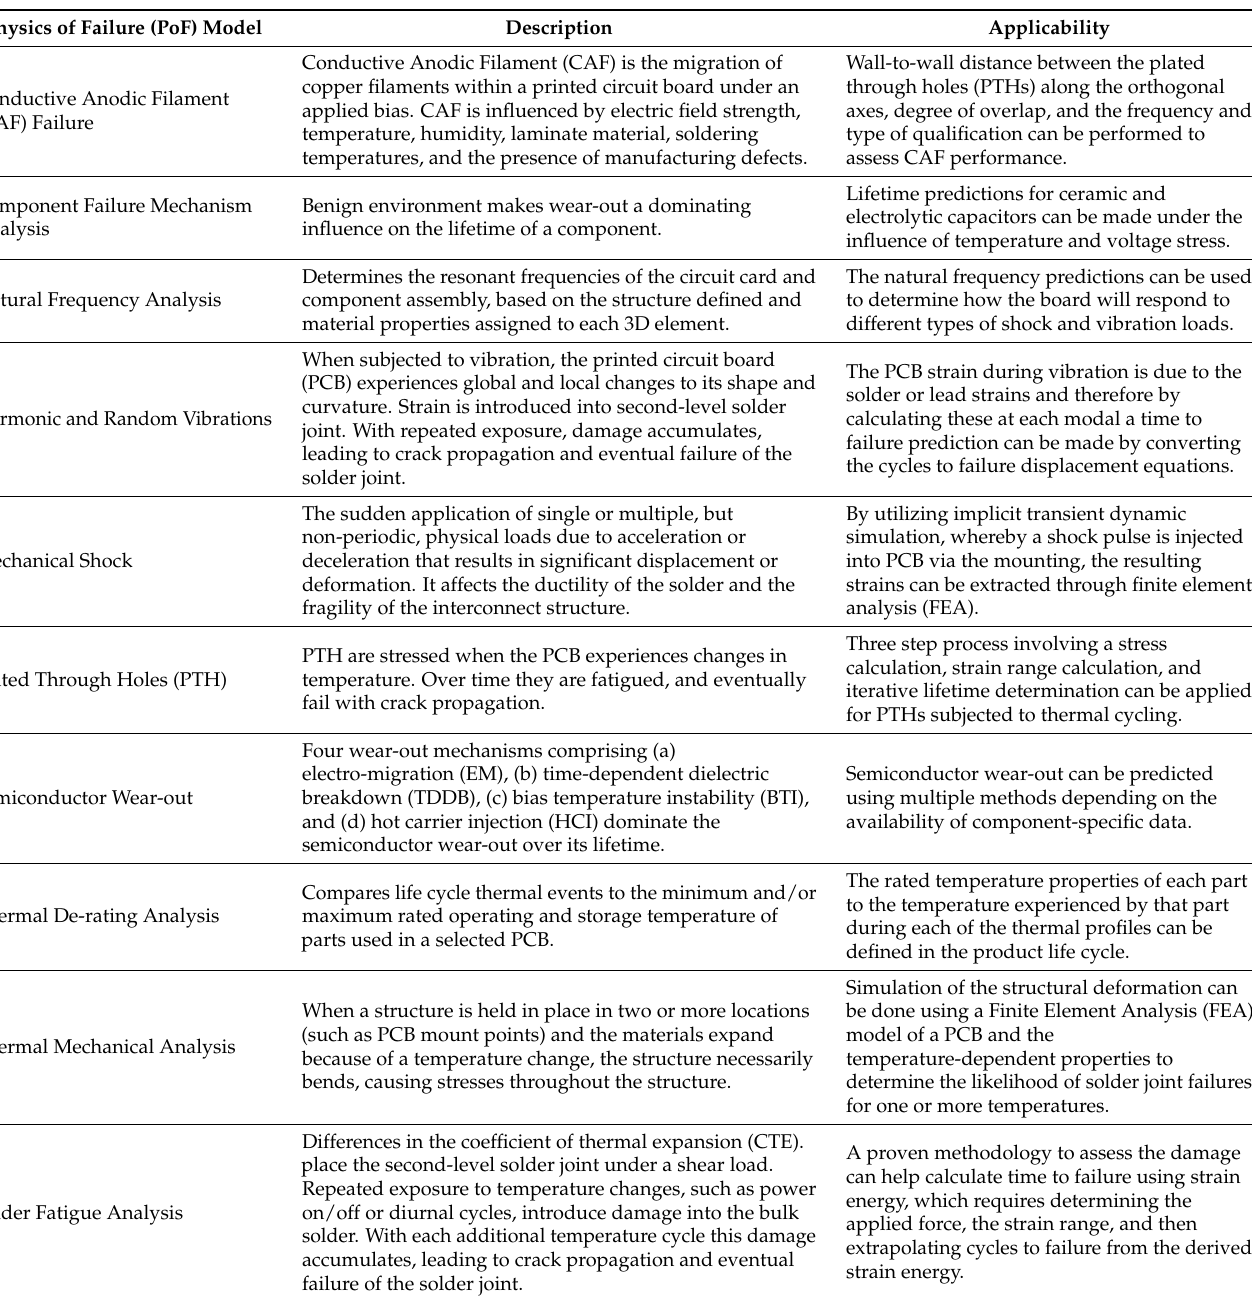
Table 1. An account of various PoF models currently applied for the analysis of power semiconductor devices when subjected to multifarious